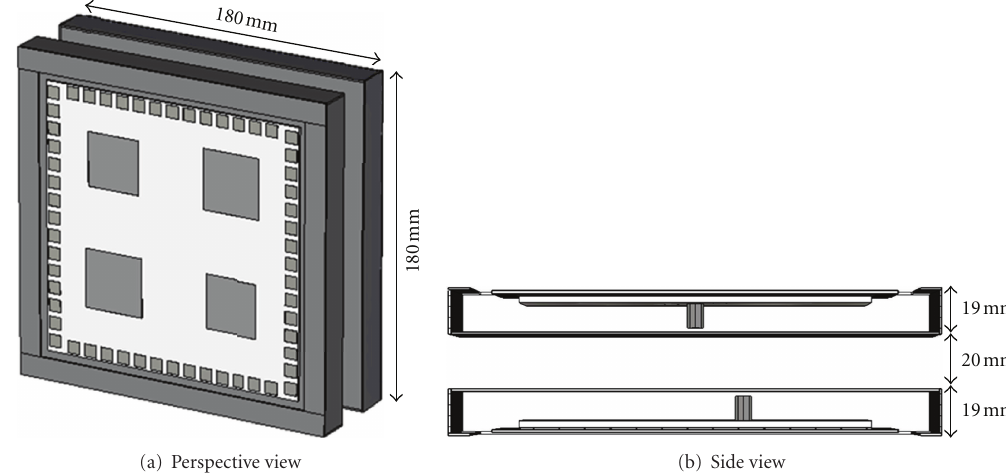
Figure 7: Geometry of the proposed indoor WCDMA repeater